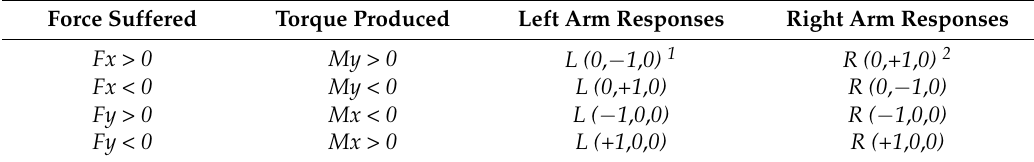
Table 1. Relationship between the forces and torques.